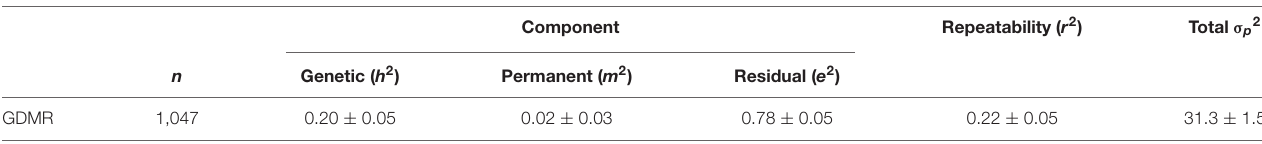
TABLE 2 | Estimates of heritability, repeatability, permanent and residual effects ( ± S.E.) for the global DNA methylation rate.